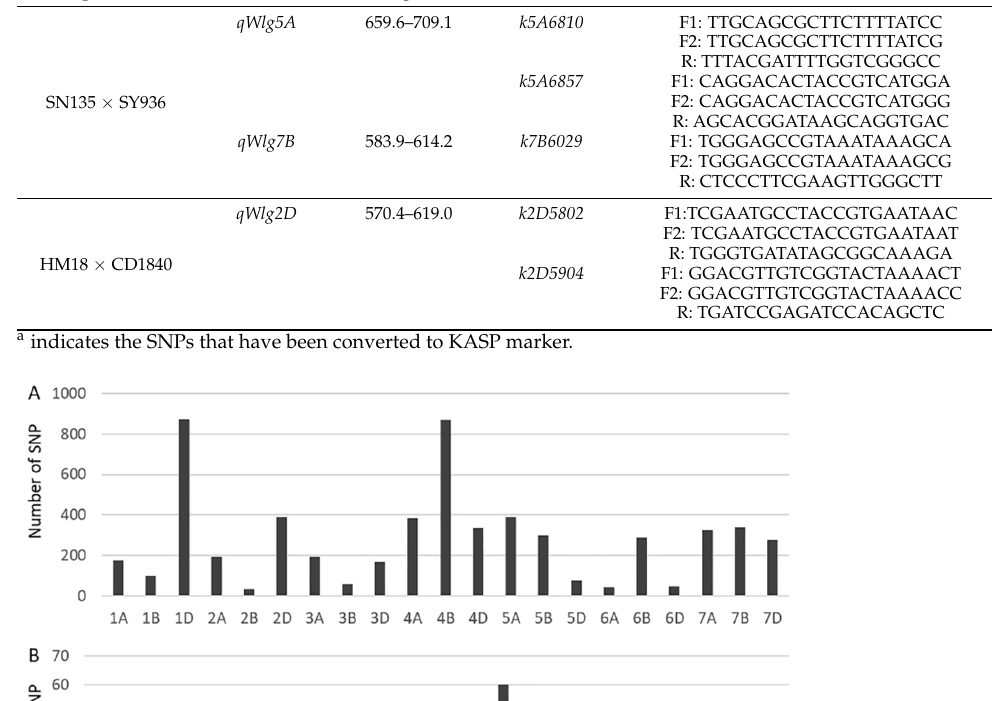
Table 2. QTL region identified for waterlogging tolerance on chromosomes 5A and 7B, and their corresponding linkage KASP markers.